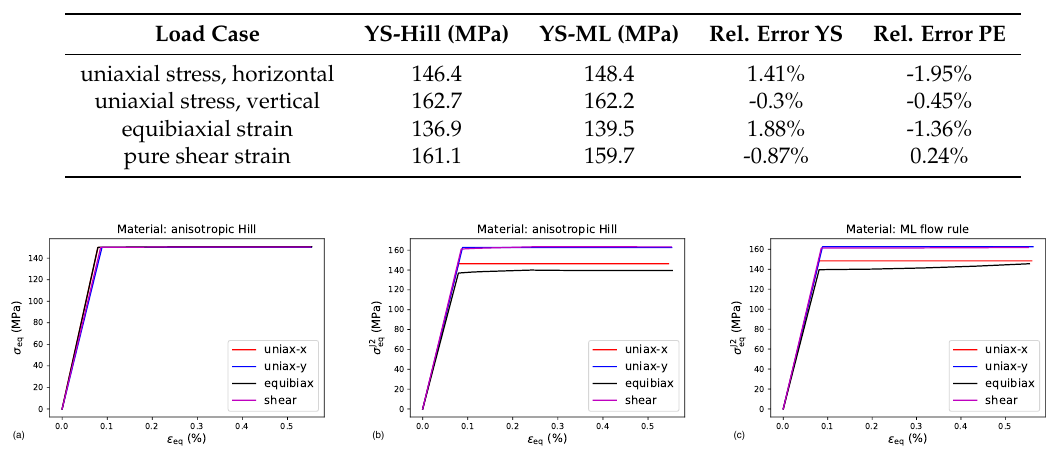
Table 2. Yield stresses (YS) obtained for Hill-like yield function, with parameters given in Table 1, and machine learning (ML) yield function under the specified load cases. The relative errors in yield stress and equivalent plastic strain (PE) at maximum load are also specified.